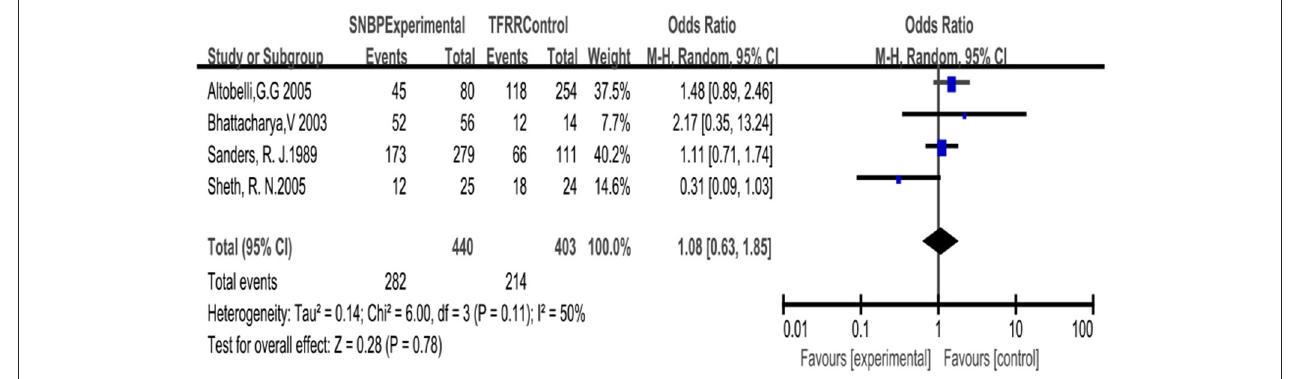
FIGURE 3 | Forrest plot for Relief of pain with SNBP and TFRR. CI, confidence interval.